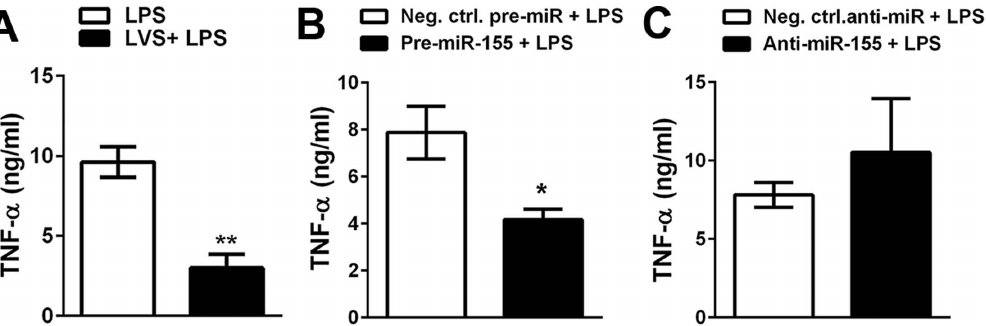
Figure 7. LVS infection and miR-155 overexpression impair LPS-stimulated TNF a secretion. A . Control MDMs or cells that had been infected with LVS for 18 h were stimulated with 100 ng/ml E. coli LPS, and after 6 h at 37 u C the amount of TNF a in the supernatant was quantified by ELISA. Data shown are the mean 6 SEM (n=3). B–C . MDMs were transfected with the indicated pre-miRs and anti-miRs 48 h prior to stimulation with E. coli LPS, and TNF a secretion was quantified as for panel A. Data are the mean 6 SEM (n=3).